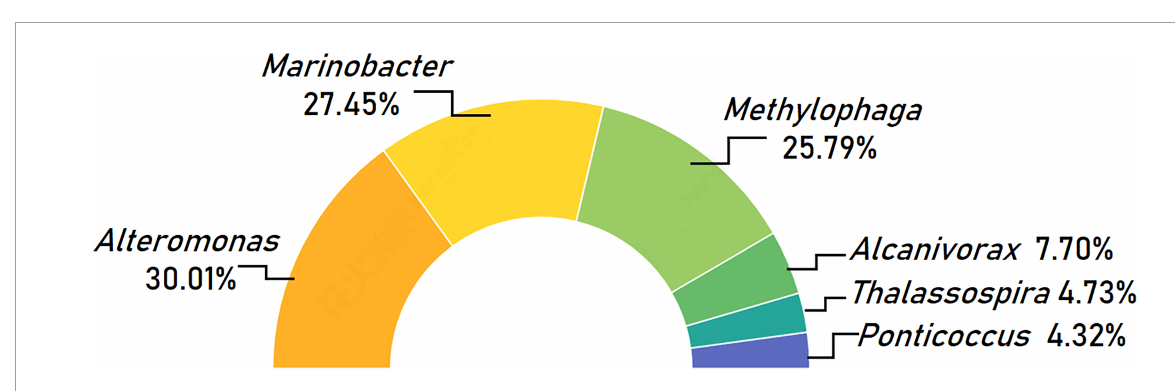
FIGURE4 Taxonomic composition of core bacterial microbiome associated with Karlodinium veneficum across different strains at the genus level. Half circle diagram represents relative abundances of bacterial genera for the core bacterial